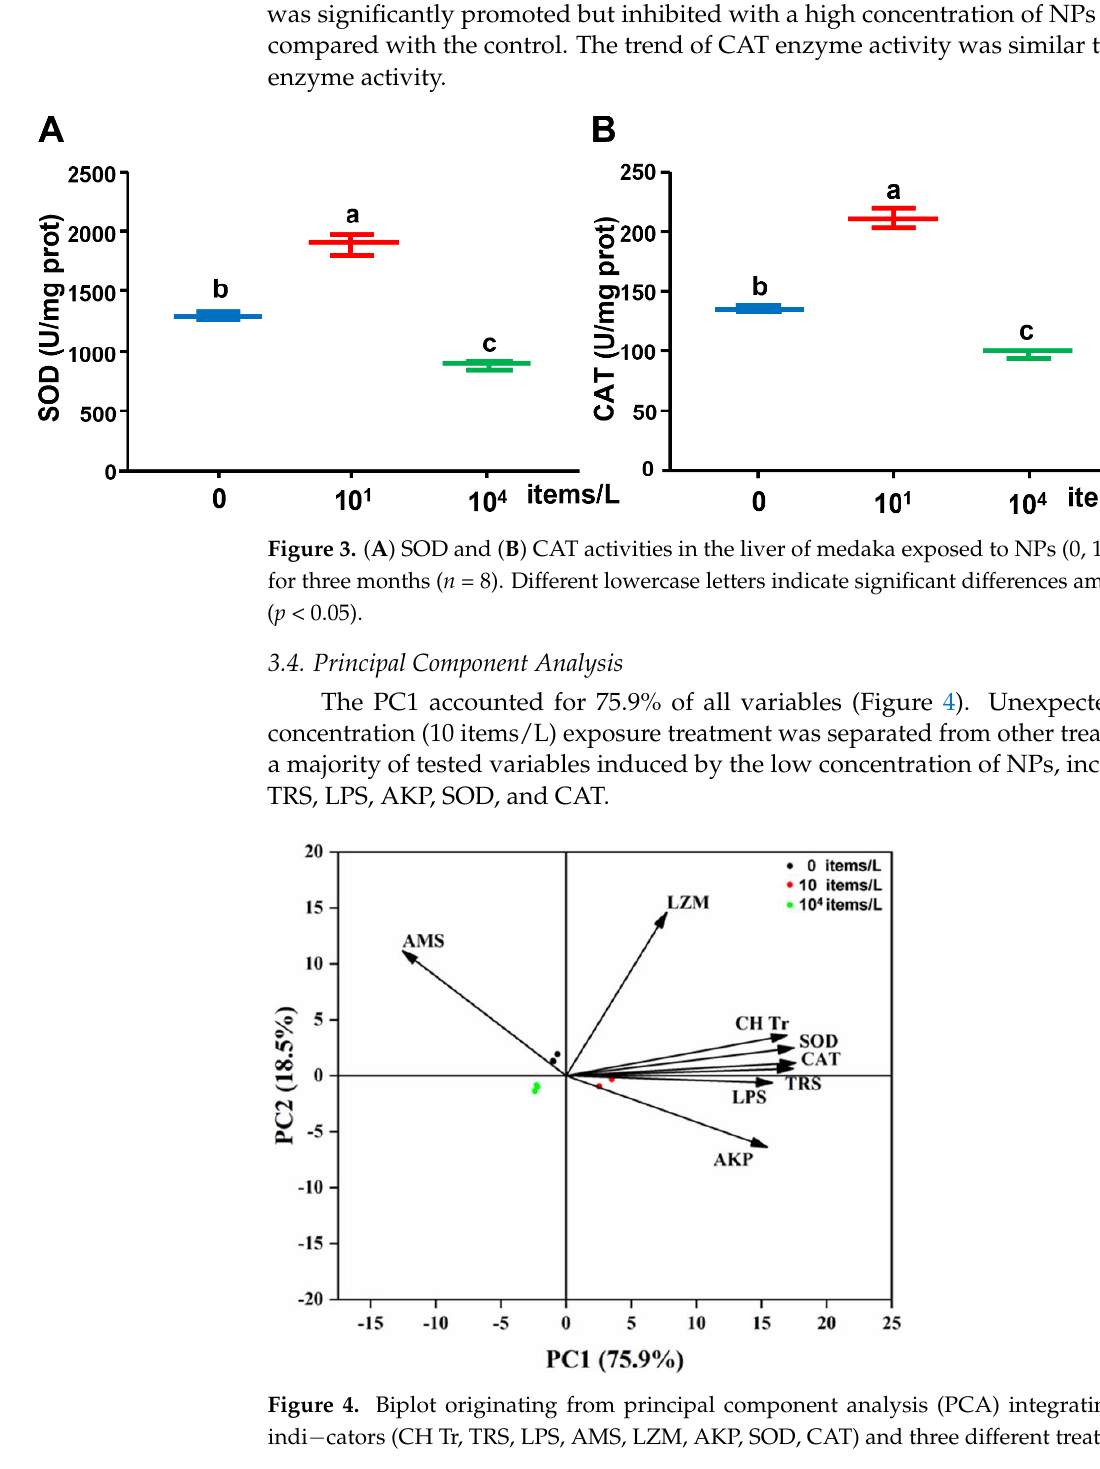
Figure 4. Biplot originating from principal component analysis (PCA) integrating biochemical indi − cators (CH Tr, TRS, LPS, AMS, LZM, AKP, SOD, CAT) and three different treatments.